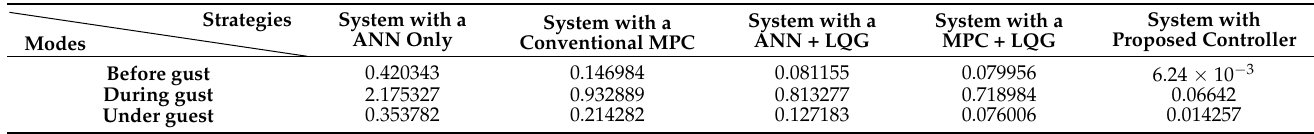
Table 2. Max overshoot percentage of generated power deviation at different operating modes and different control strategies.